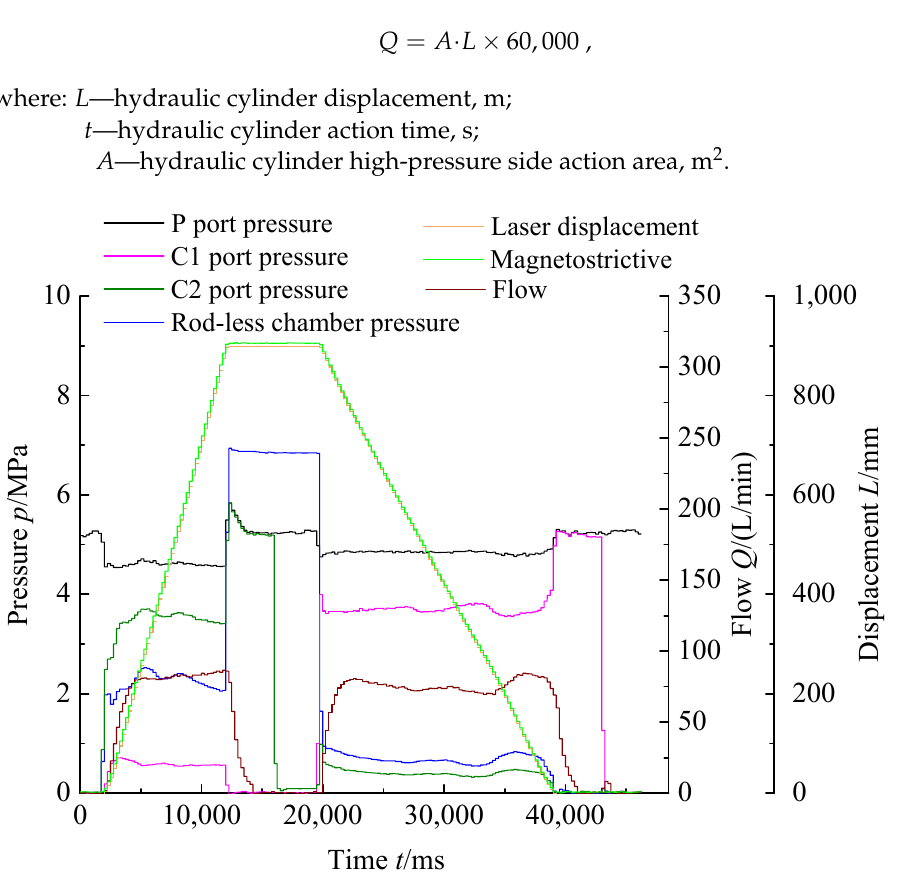
Figure 5. Full stroke mean filtering data of DN20 supply pipeline under 5 MPa system